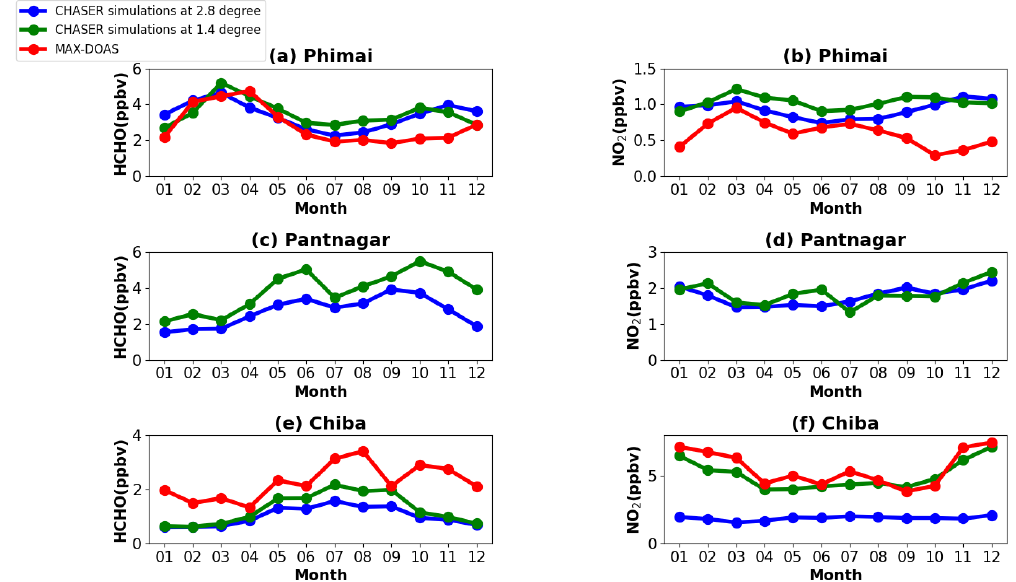
Figure 14. Seasonal variation in the surface HCHO and NO 2 mixing ratios at (a, b) Phimai, (c, d) Pantnagar, and (e, f) Chiba simulated at spatial resolutions of 2.8 ◦ × 2.8 ◦ (blue) and 1.4 ◦ × 1.4 ◦ (green). Coincident MAX-DOAS NO 2 and HCHO VMRs in the 0–1km layer at Phimai and Chiba are plotted in red. Observations at Pantnagar are discarded. Only the datasets for 2017 are